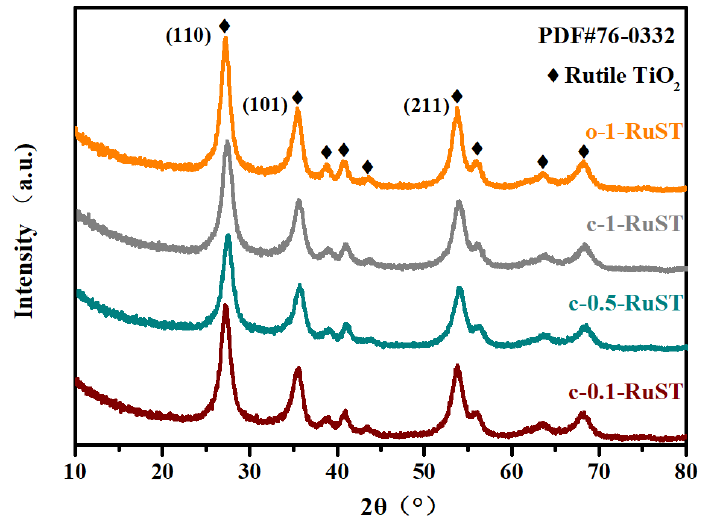
Figure 3. XRD patterns of the samples. Peak information for crystal plane acquired from the ICSD Powder Diffraction File card of Rutile TiO 2 (card No. 76-0332) is also marked in the figure.